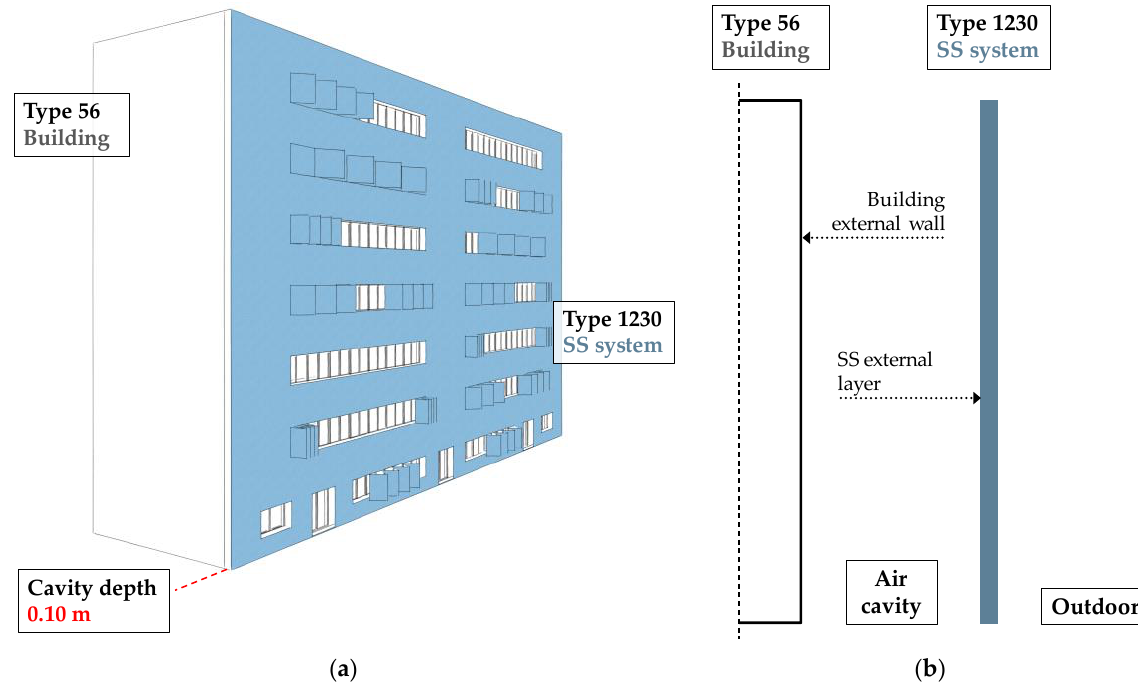
Figure 6. Schematic view of Type 56 (building) and Type 1230 (SS facade system): ( a ) axonometry and ( b ) section.